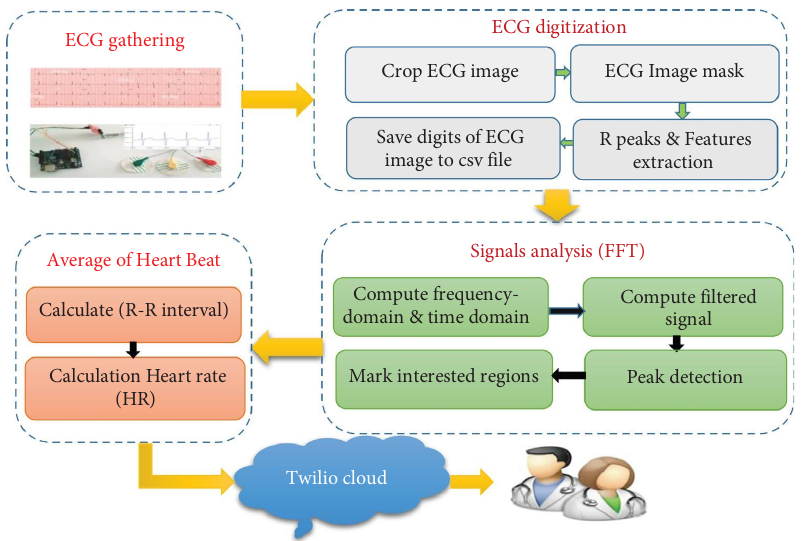
Figure 2: Proposed